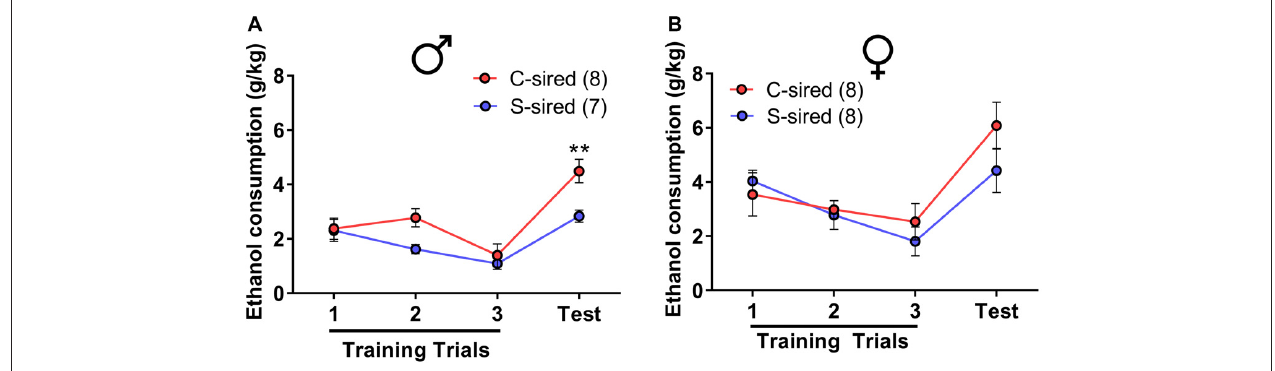
FIGURE 4 | No effect of paternal chronic stress on hypothalamic-pituitary-adrenal (HPA) responsivity in offspring. No effect of paternal stress on (A) male ( N = 8/group) or (B) female ( N = 8/group) corticosterone (CORT) levels at 0, 15 30 and 90 min from the onset of 15-min restraint stress (represented by shaded bar).